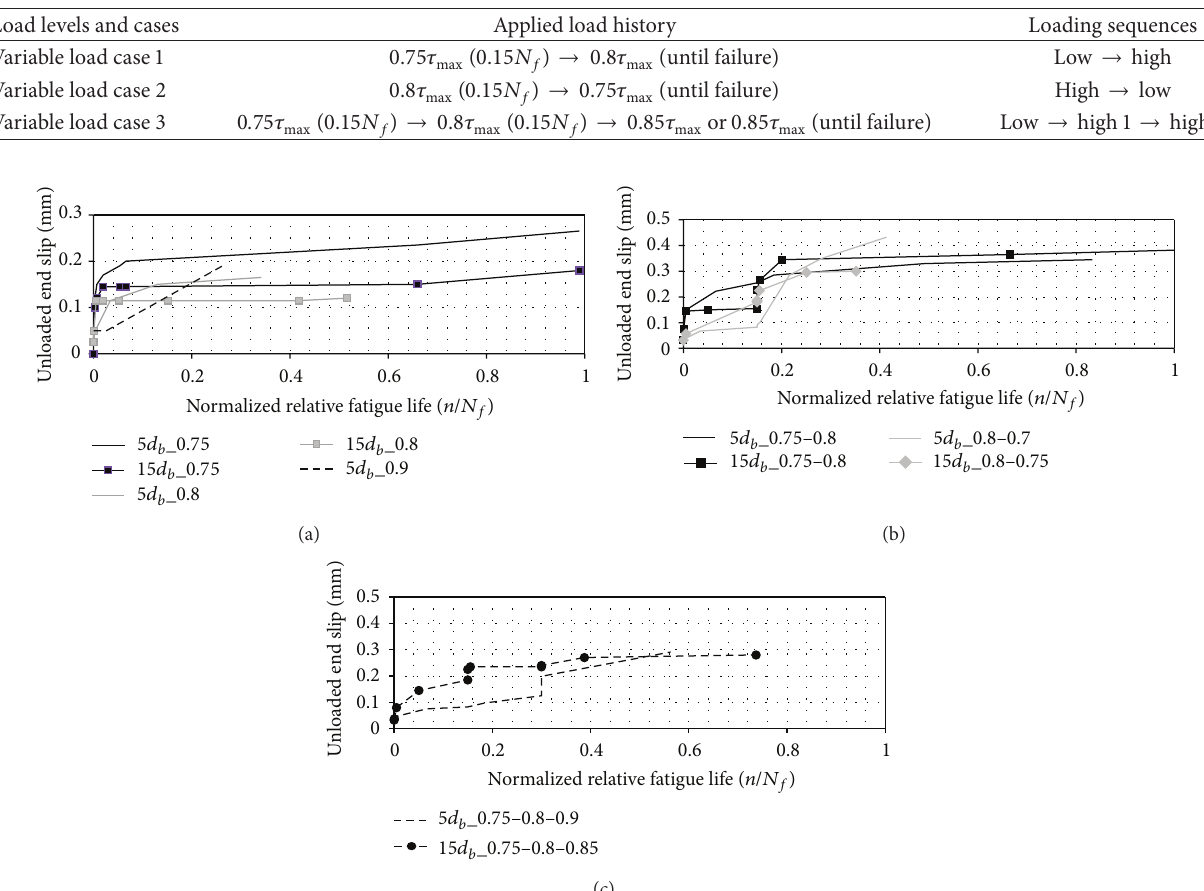
Table 4: Stress level of the fatigue bond test.